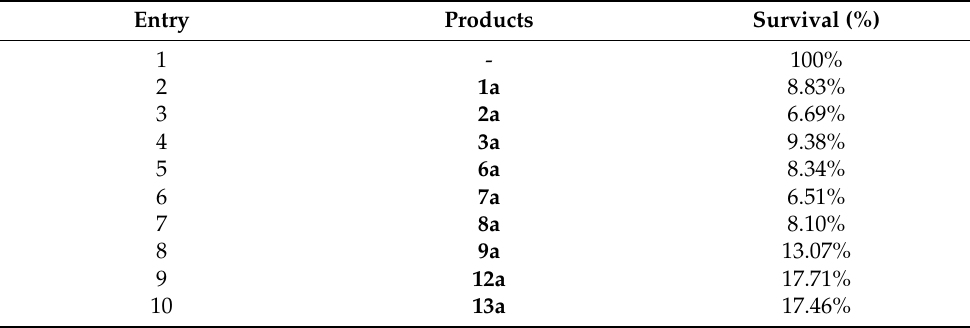
Table 4. Cell survival rate of tested cyclic sulfamates (10 µ M) against MCF-7